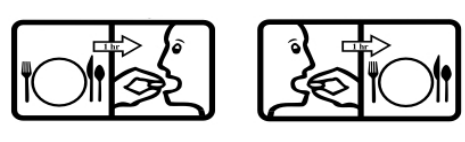
Figure 1. Pictogram